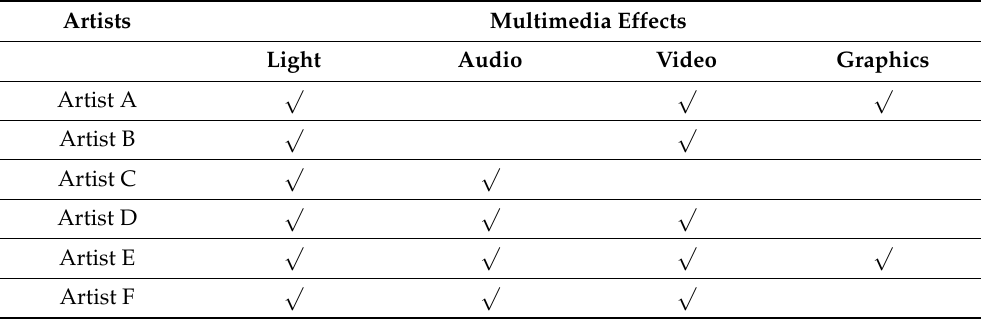
Table 4. The use of multimedia effects in sculpture as understood by traditional sculpture artists.